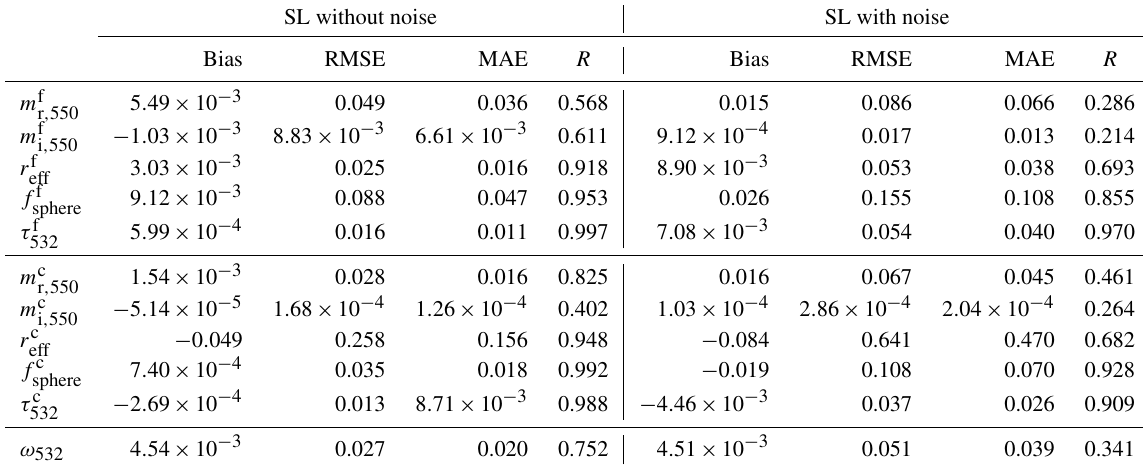
Table 4. Results for retrievals with the 3 α + 3 β + 3 δ pol super-lidar (SL) configuration with and without